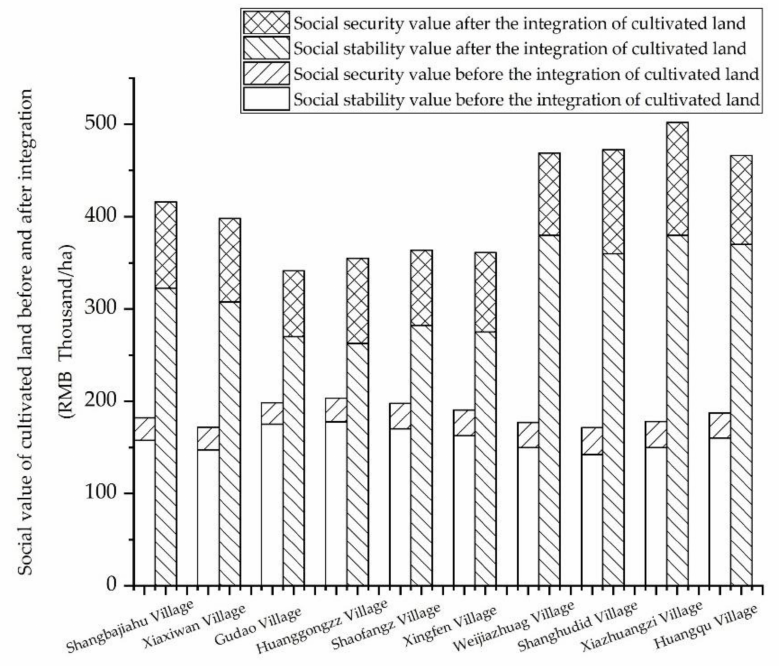
Figure 4. Social value before and after the integration of cultivated